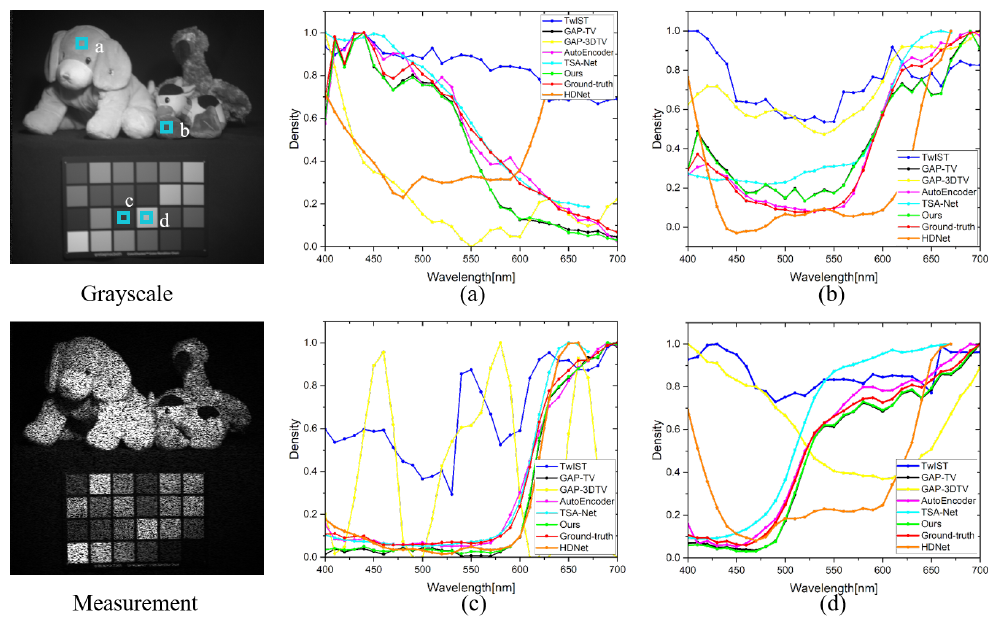
Figure 9. Grayscale image and corresponding compressive measurement by the spatio-spectral encoding of stuf fed toys from the CAVE dataset. The right two columns display the reconstructed spectral curves on special regions to compare the spectral accuracy. ( a ) The spectral curves at point a;